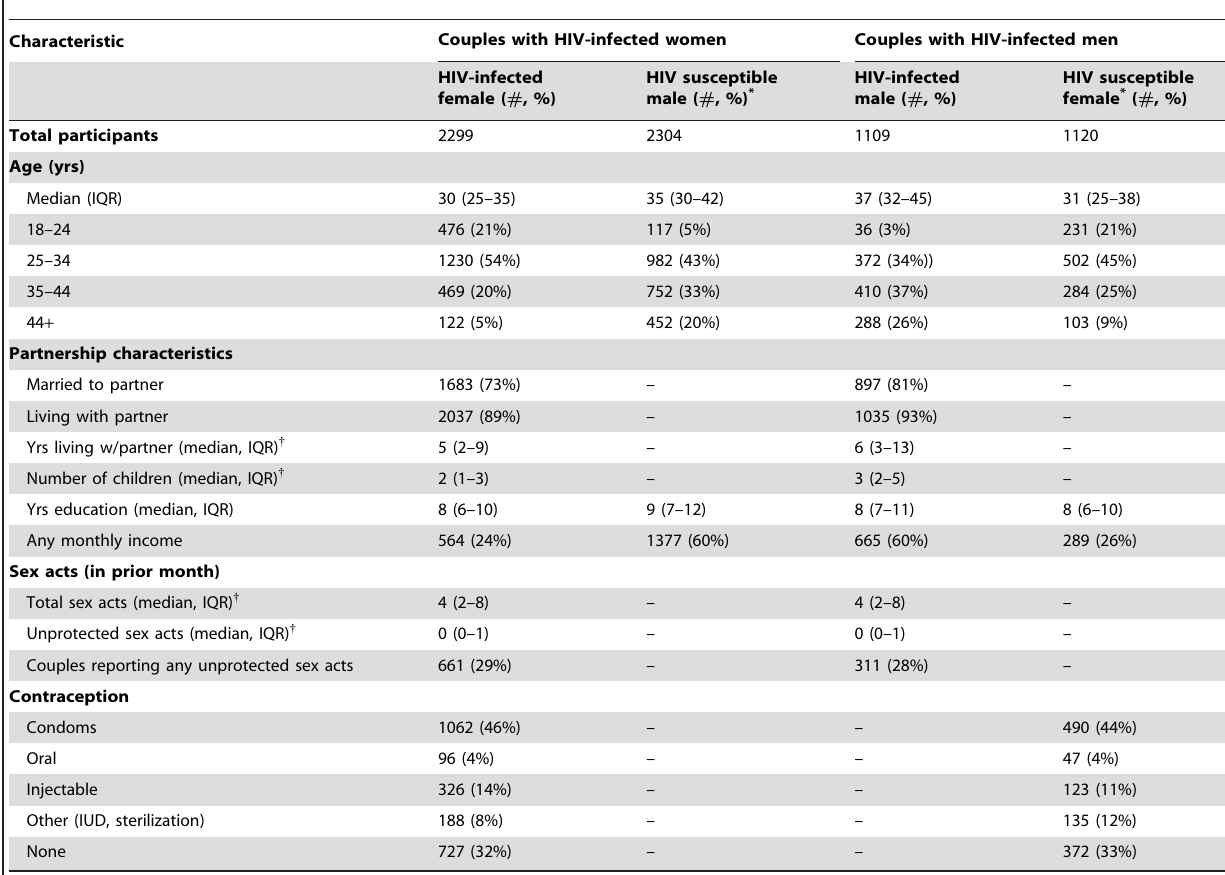
Table 3. Baseline Demographic and Behavioral Characteristics of Enrolled Couples by Gender of HIV-infected Partner.